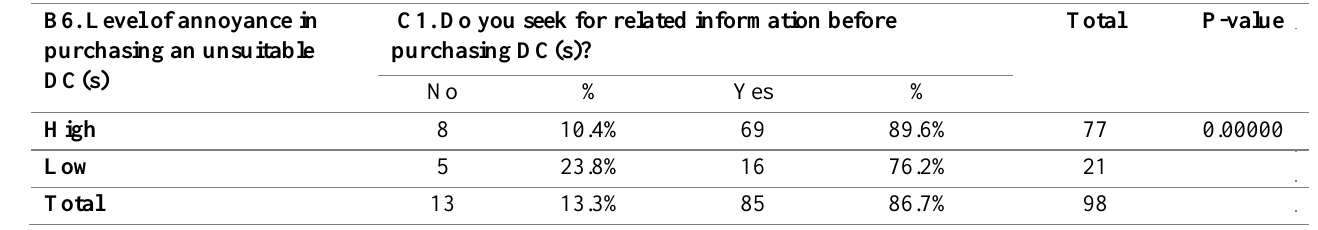
Table 8. Result For Hypothesis 7 Table 5. Result For Hypothesis 4